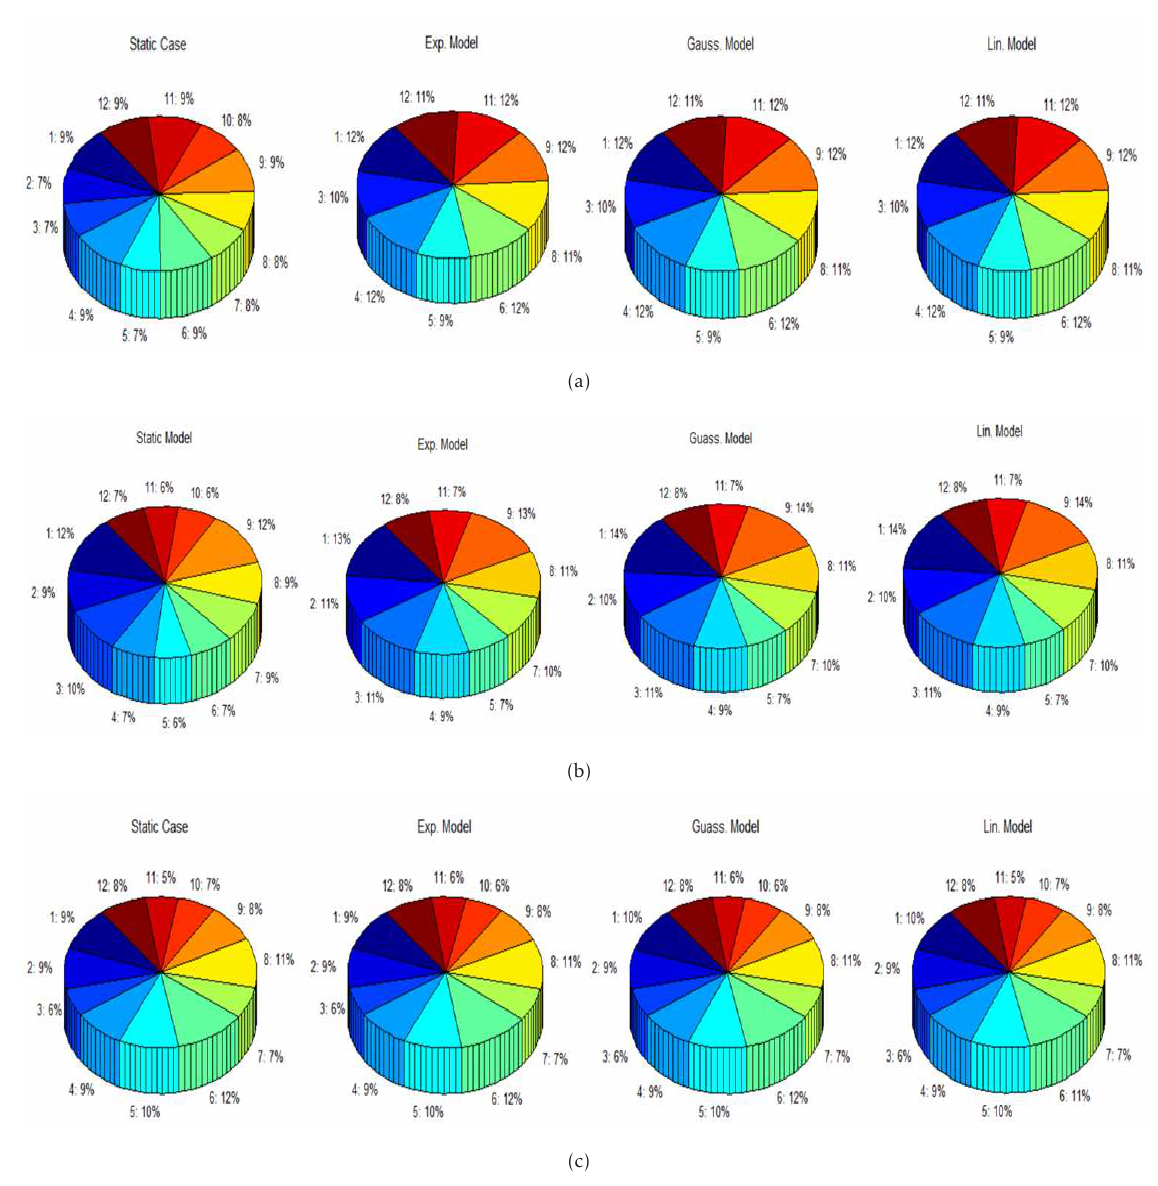
Figure 7. Flow satisfied proportions in percentages w.r.t RSU index (a) Traffic density, β = 0 . 1 (b) Traffic density, β = 0 . 25 (c) Traffic density, β = 0 . 5